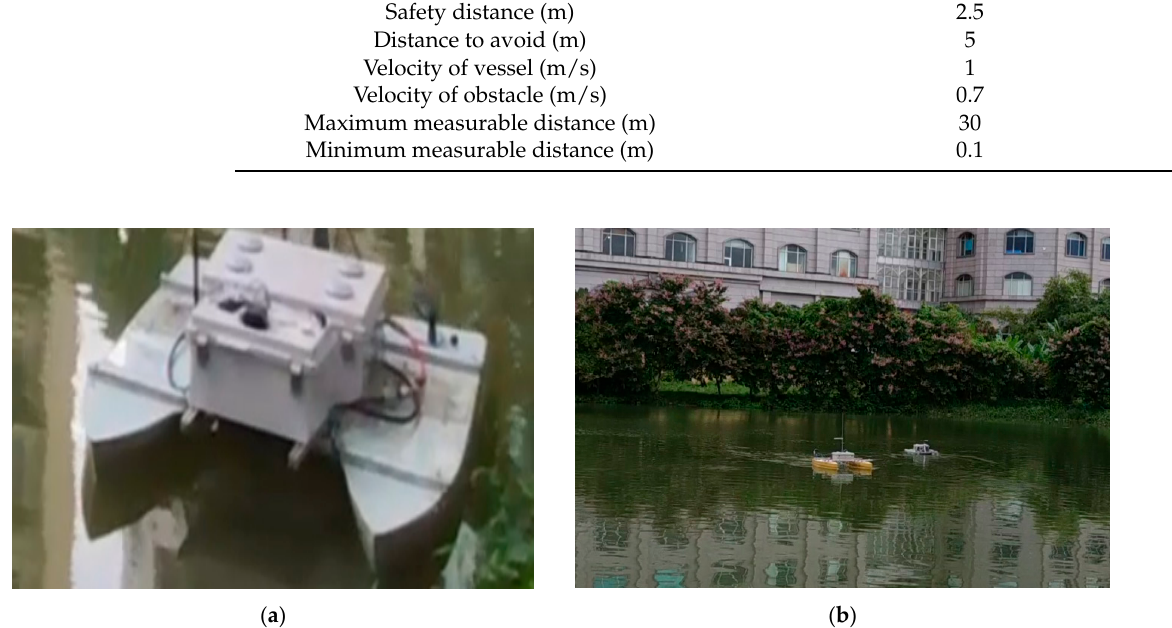
Figure 17. Targeted vessel being an obstacle in ( a ); obstacle avoidance process in ( b